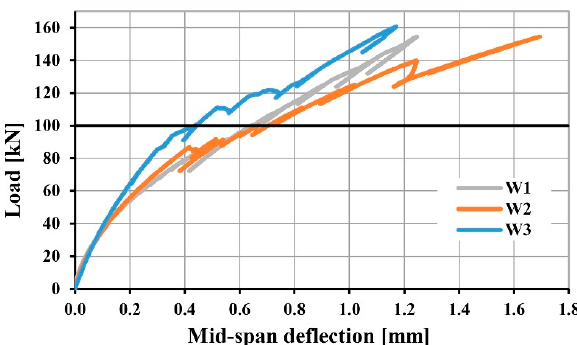
Figure 23. Mid-span deflection at the measuring point D3 of members W1, W2, and W3. Appl. Sci. 2020 , 10 , x FOR PEER REVIEW